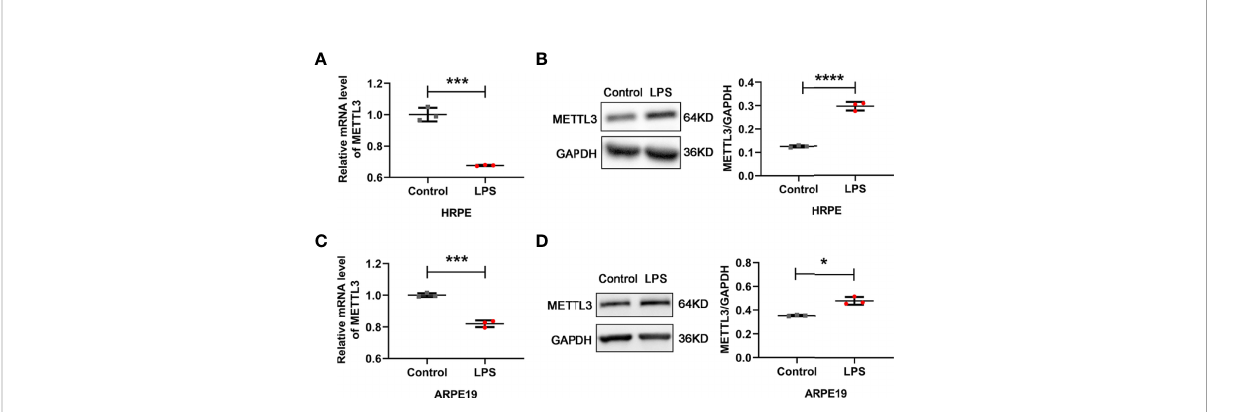
FIGURE 1 Expression of METTL3 in RPE cells after LPS stimulation. (A, C) mRNA level of METTL3 in LPS treated hRPE and ARPE19 cells (mean ± SD; *** P<0.001; n=3/group; unpaired Student ’ s t-test). (B, D) Protein level of METTL3 in LPS treated hRPE and ARPE19 cells. Left, representative western blotting images of METTL3. Right, quanti fi cation of relative expression of METTL3 (mean ± SD; * P<0.05, **** P<0.0001; n=3/group; unpaired Student ’ s